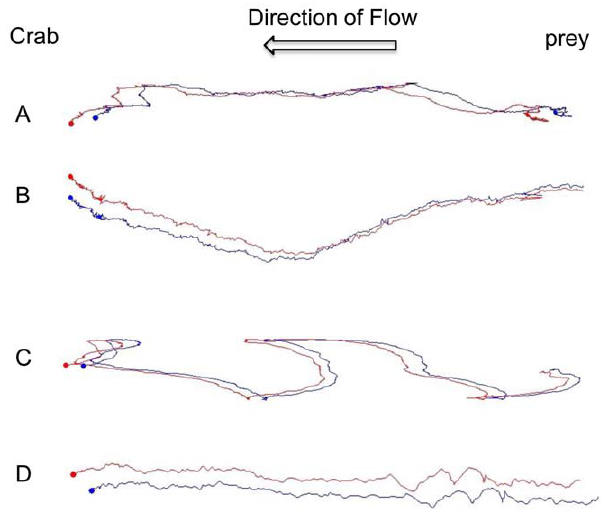
Figure 4. Example path trajectories of successful, foraging green crabs in the flume at U =(A) 3 cm s 2 1 tile, (B) 15 cm s 2 1 tile, and (C) 19 cm s 2 1 tile. An example of an unsuccessful green crab is presented as trajectory (D). The two lines for each trajectory represent the two tracking markers located on the carapace of the green crab. 3 cm s 2 1 trials were performed in the DMC flume.